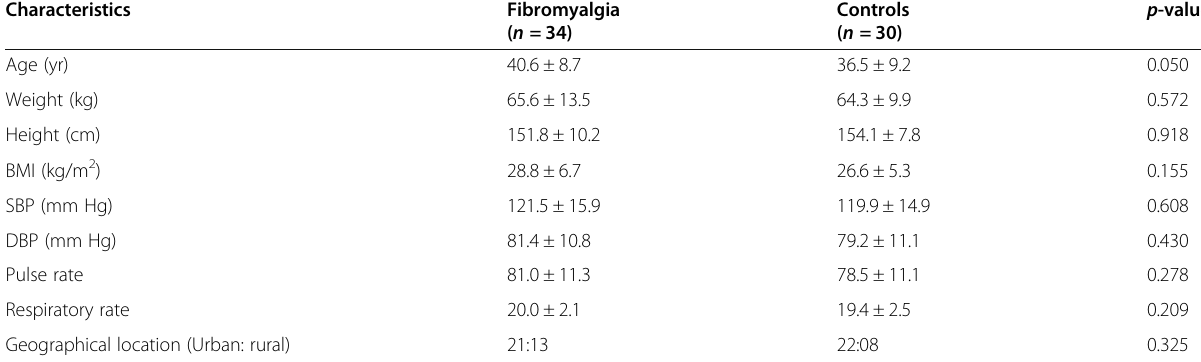
Table 1 Demographic parameters comparison between patients of fibromyalgia and pain-free controls Characteristics